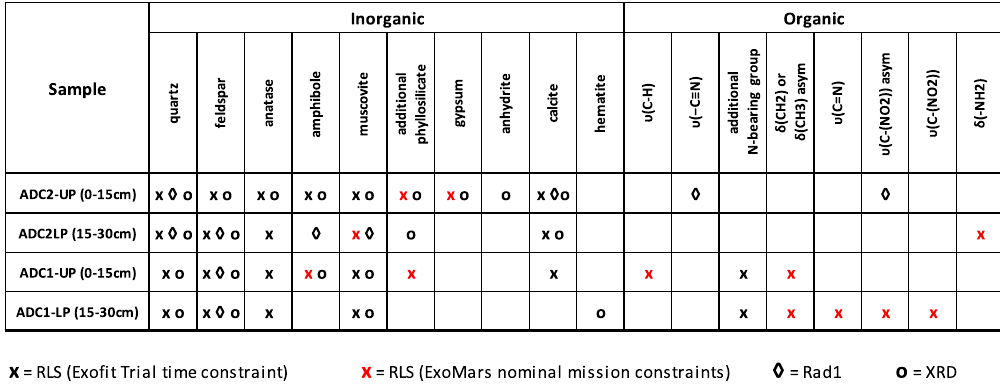
Table 1. Summary of organic and inorganic phases detected through the analytical study of ADC1 and ADC2 drilled